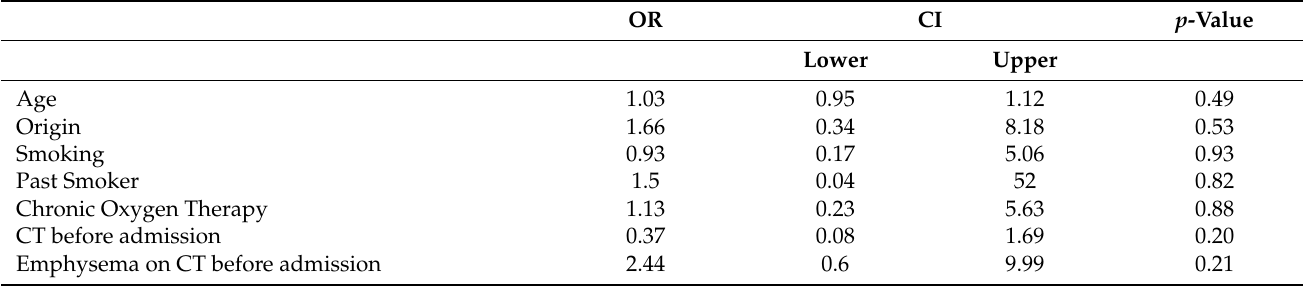
Table 3. Multivariate analysis of factors associated with having a confirmed COPD